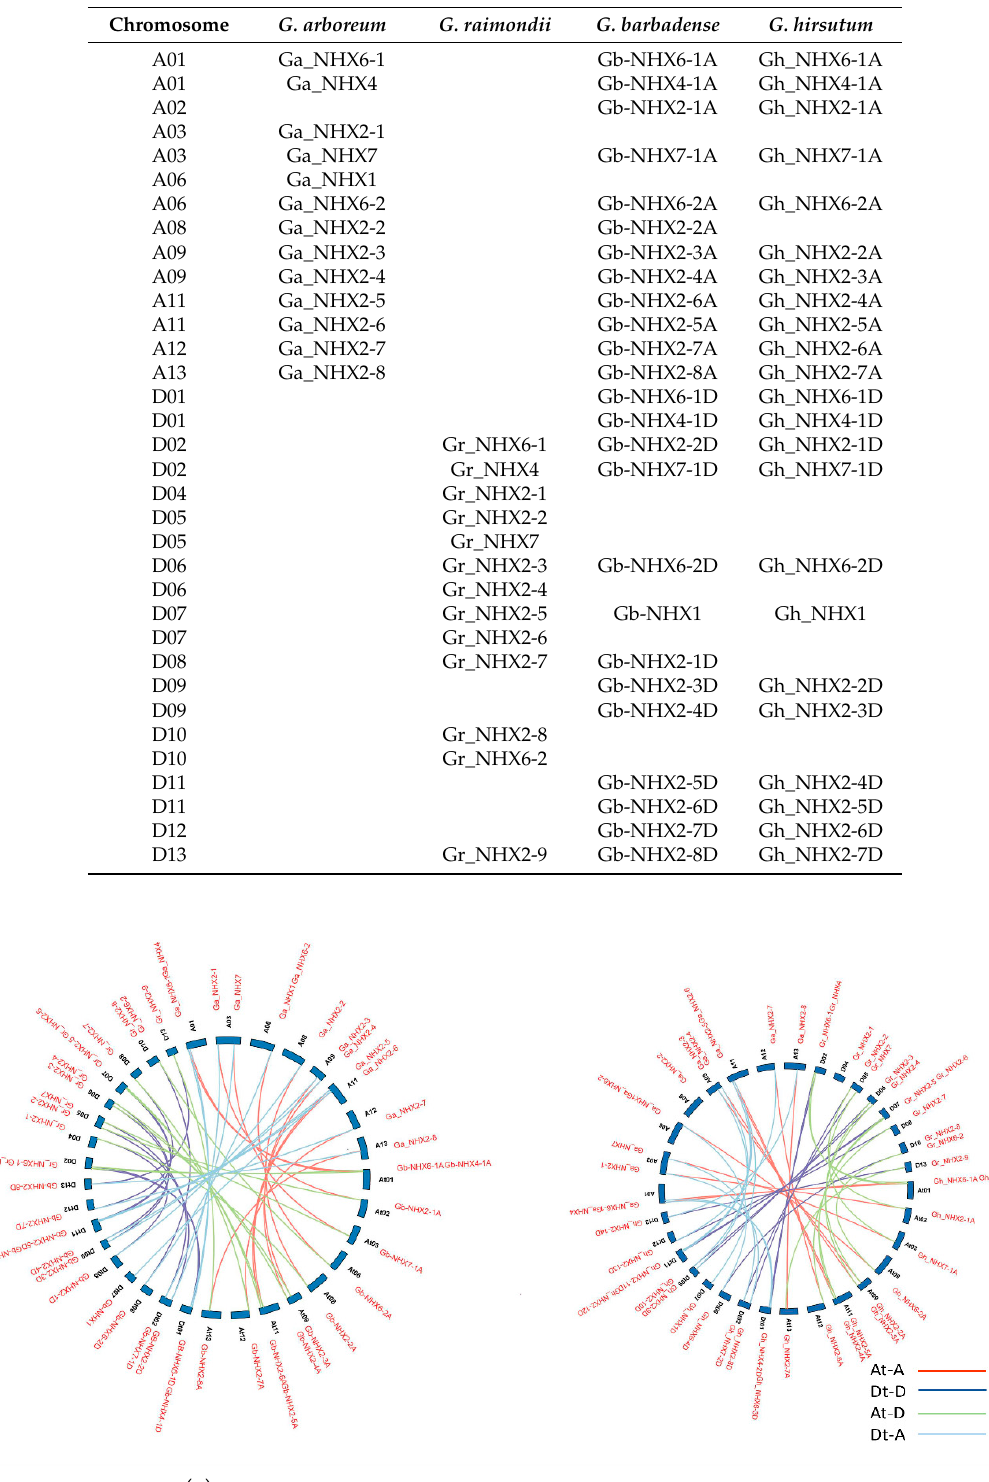
Table 2. Chromosomal location of the NHX genes in the Gossypium species.